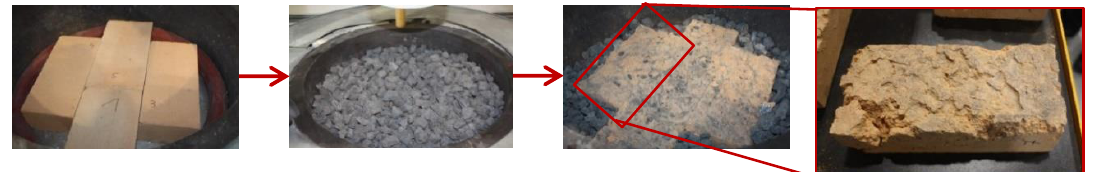
Figure 14. UCT of perlite brick insulation.